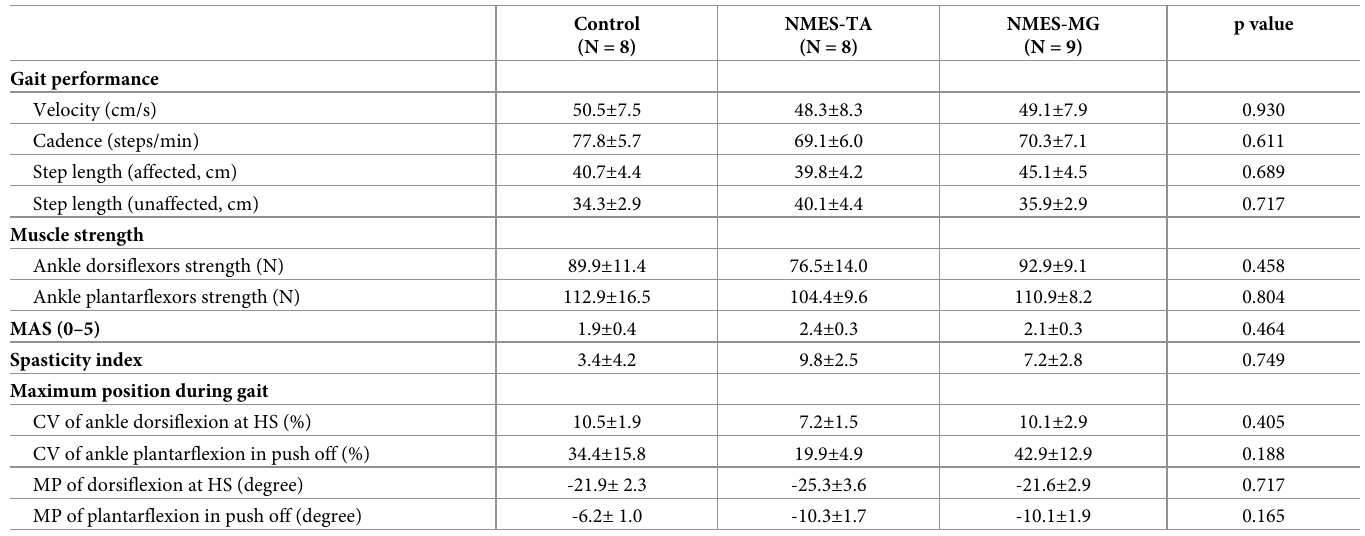
Table 2. Baseline data of the